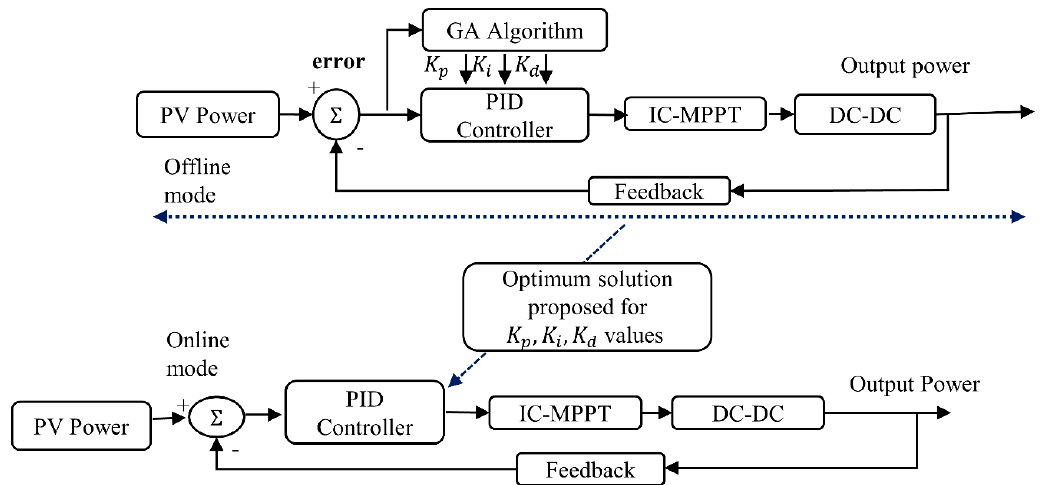
Figure 10. Offline tuning and real-time utilization of PID controller.